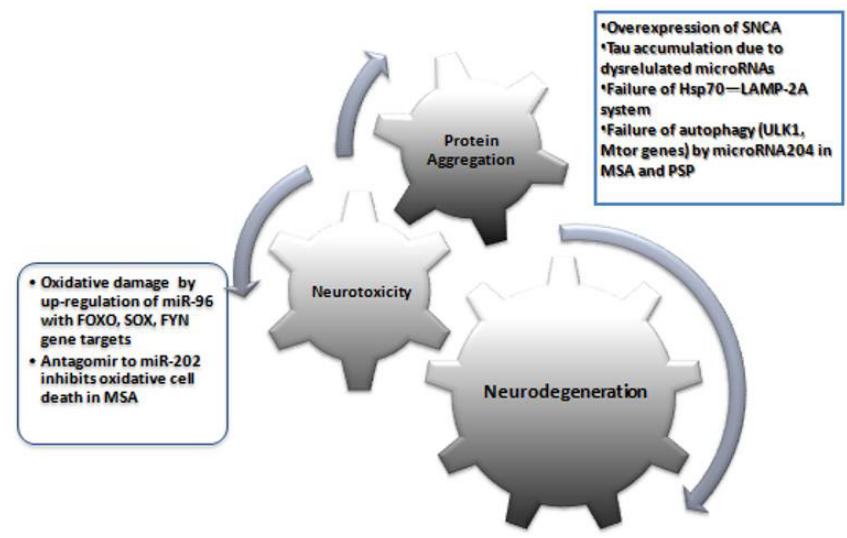
Figure 2. An overview of major pathogenetic mechanisms in atypical parkinsonian syndromes MSA and PSP and the proposed role of miRNAs.